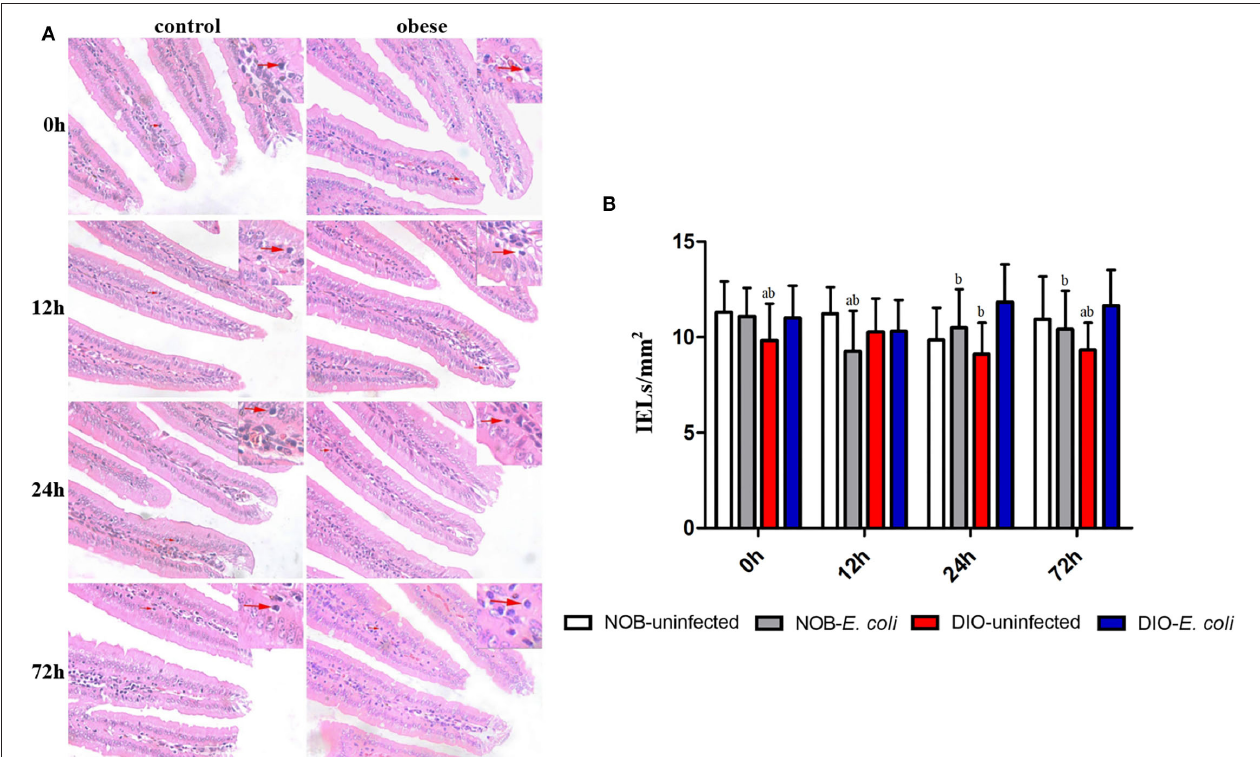
FIGURE 2 | The counting of duodenal intestinal epithelium (IELs) of each group in 0, 12, 24, and 72h post-infection. (A) Representative photomicrographs of H&E-stained duodenum of mice in control (NOB- E. coli ) and obese (DIO- E. coli ) group. 0, 12, 24, and 72h were the time points after the mice were nasally instilled with E. coli . Images were taken at 400 × magnification. n = 8 mice per group. The red arrow points to the lymphocytes in the duodenal epithelium. (B) Statistical analysis of duodenal IELs counts per mm 2 in H&E-stained sections of each group in 0, 12, 24, and 72h post-infection. a, p < 0.05 compared with group NOB-uninfected; A, p < 0.01 compared with group NOB-uninfected; b, p < 0.05 compared with group DIO- E. coli ; B, p < 0.01 compared with group DIO- E. coli